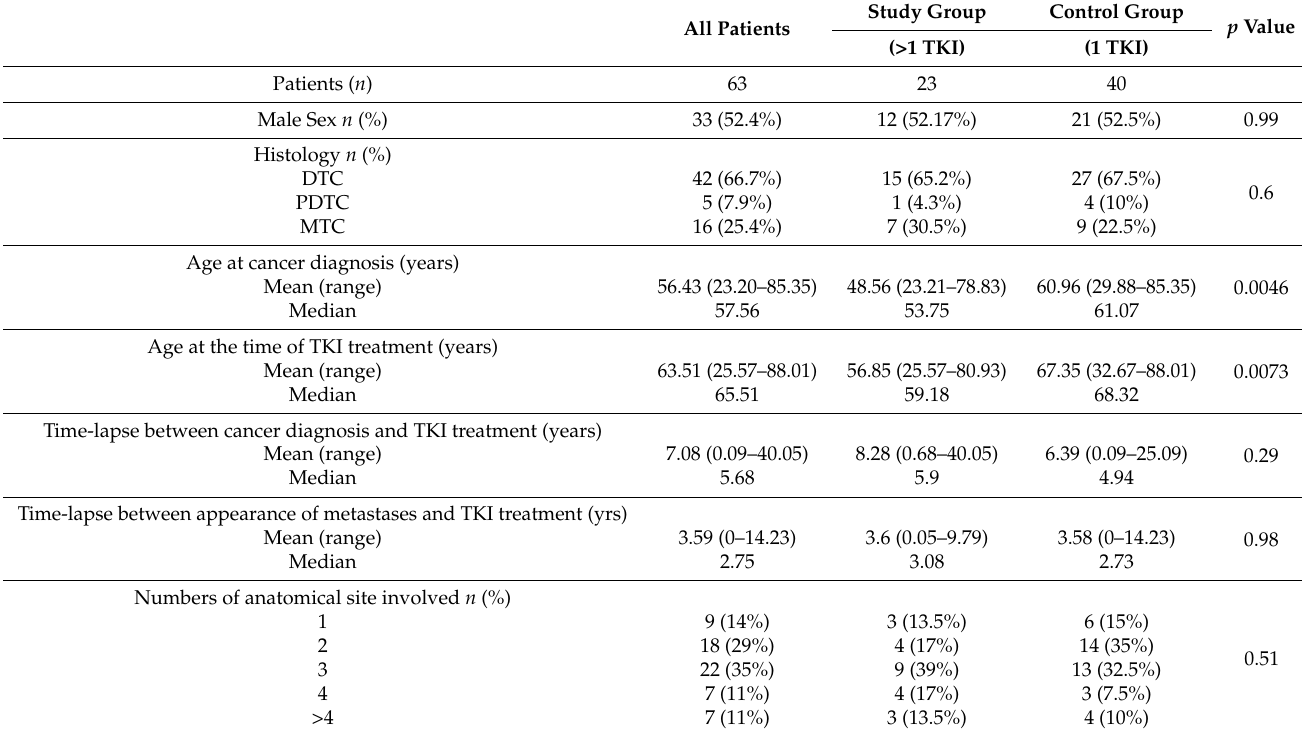
Table 1. Patient characteristics for the whole population ( n = 63) and comparison between Study group ( n = 23) and Control group ( n =